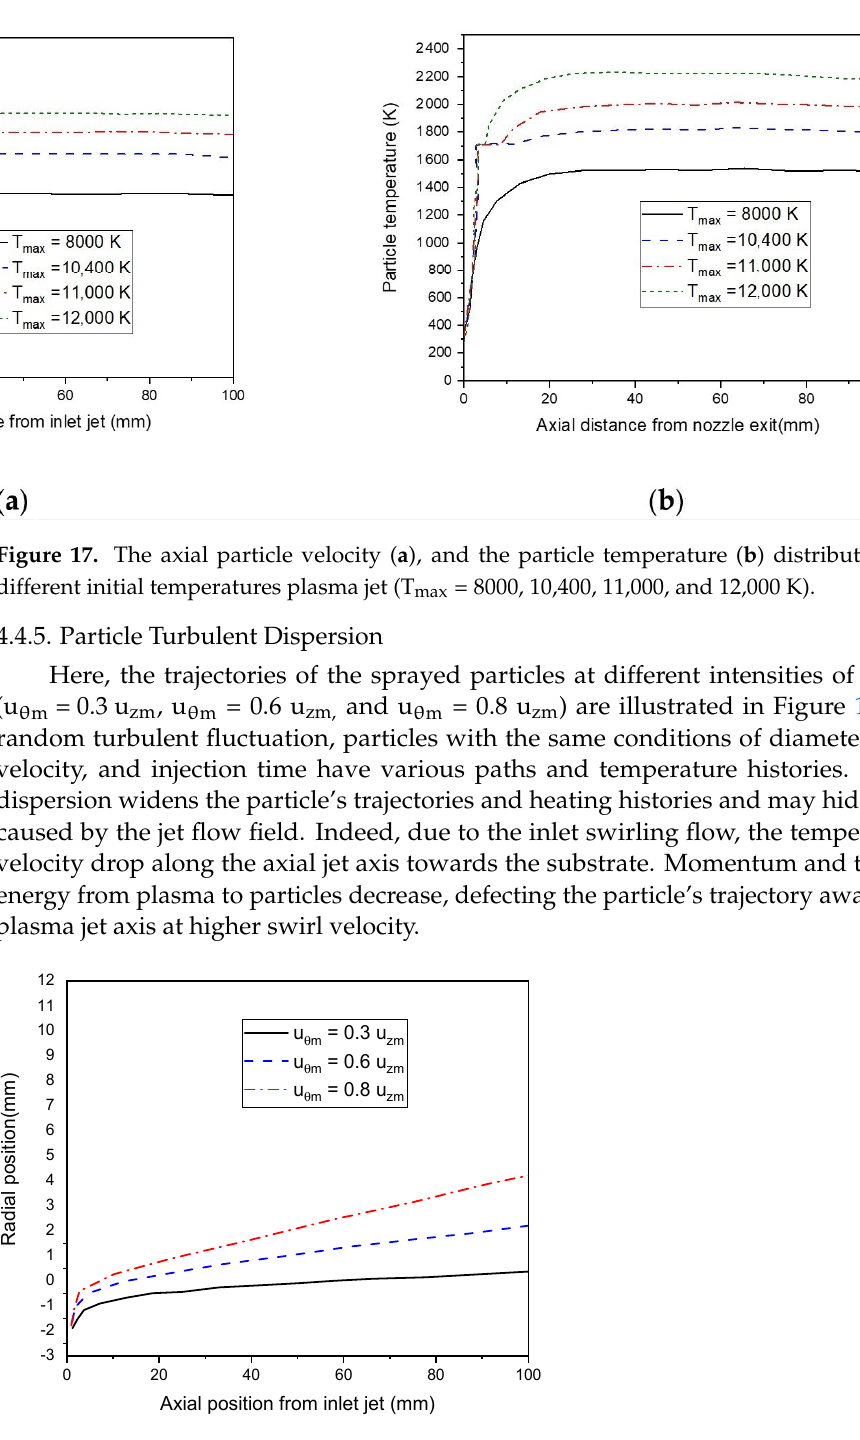
The effect of an injection of Si particles on the non-transferred turbulent argon plasma jet is investigated, using a three-dimensional numerical model. Plasma thermo-fluid dynamics, precursor-paths, particle growth process, and thermal history are described using a simulation model. The effect of different precursor flow rates, diameters, and the numbers of particles are examined, to determine the optimal growth conditions. The swirling flow reduces the localized vortex, and decreases transferred energy and momentum